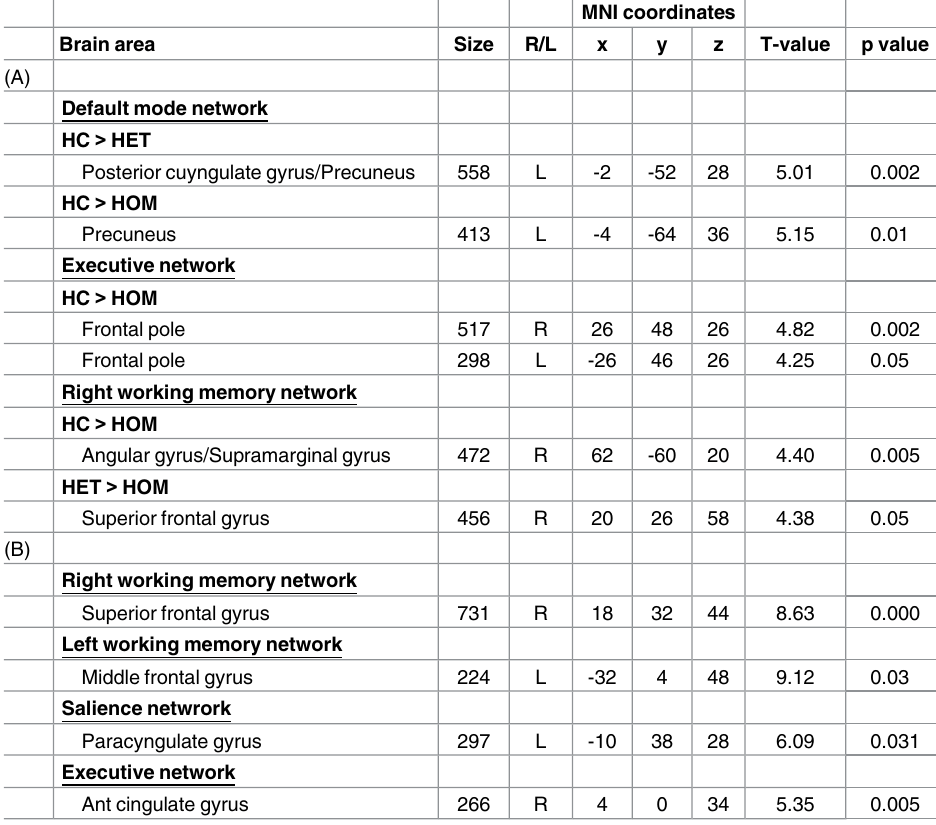
Table 3. Changes in FC in five networks of interest. Brain areas of significant FC alteration in RS-net- works (A) and of significant correlationbetween Corsi score and FC (B) HOM